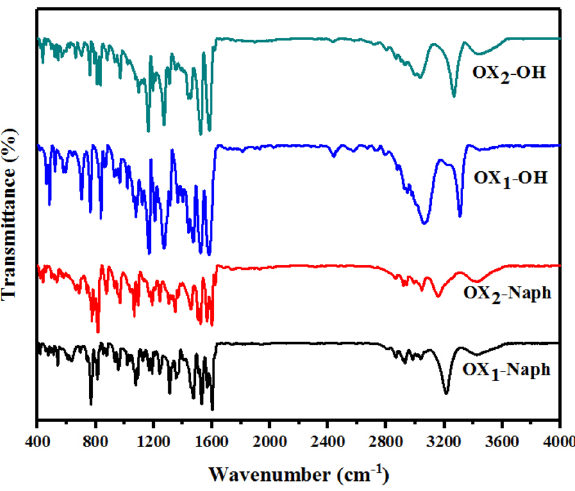
Figure 2. Chemical structure analysis of the oxazolidine derivatives by FTIR